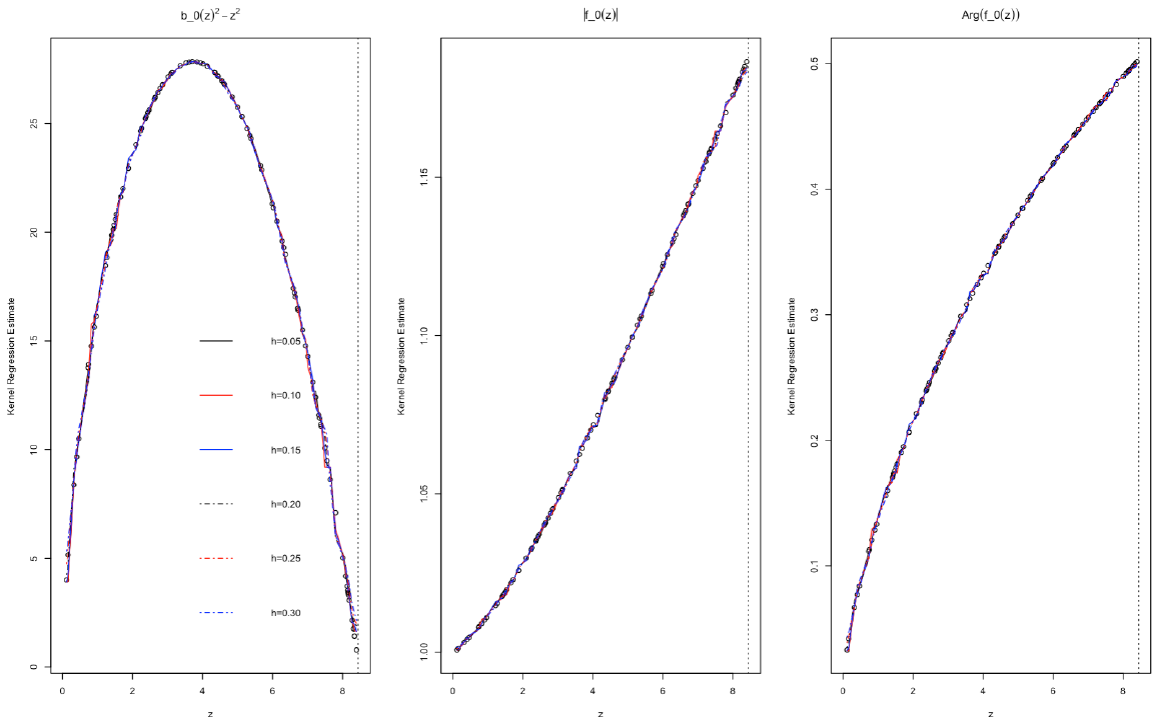
Figure 11. The estimates of critical collapse functions corresponding to a γ solution of a hyperbolic case based on a kernel regression method with bandwidth parameters h =